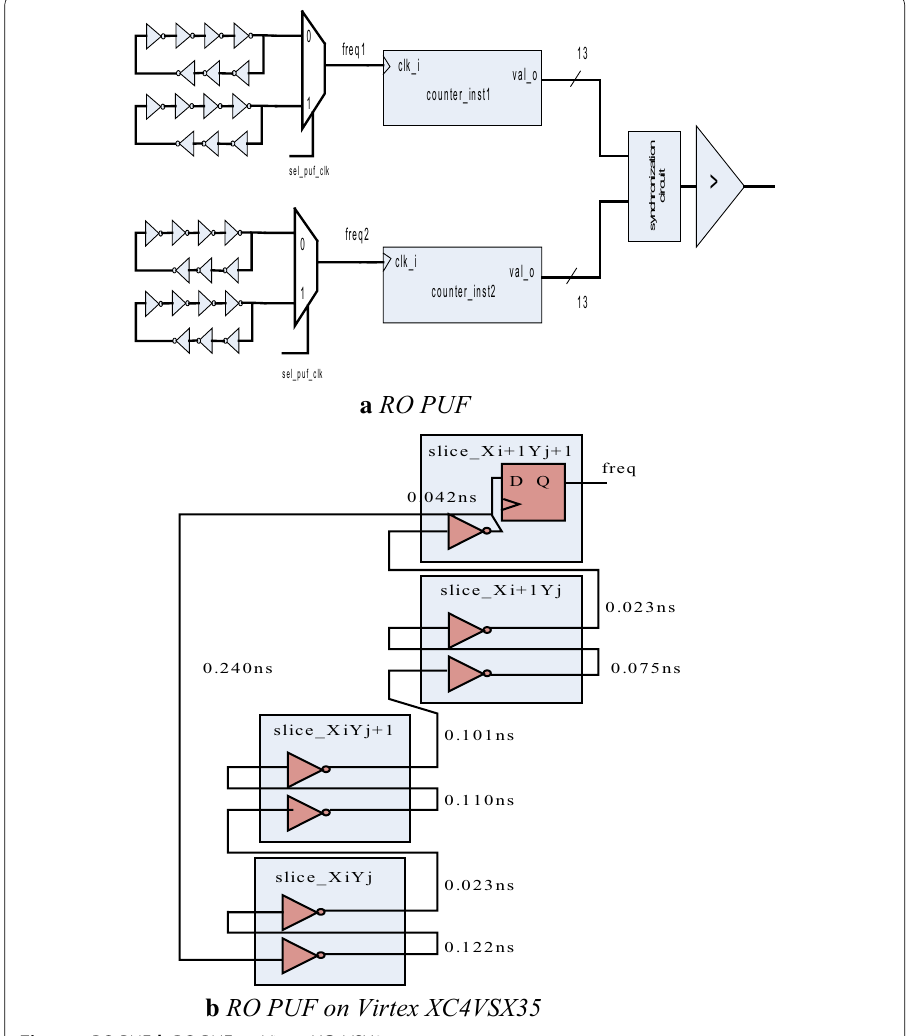
Fig. 7 a RO PUF, b RO PUF on Virtex